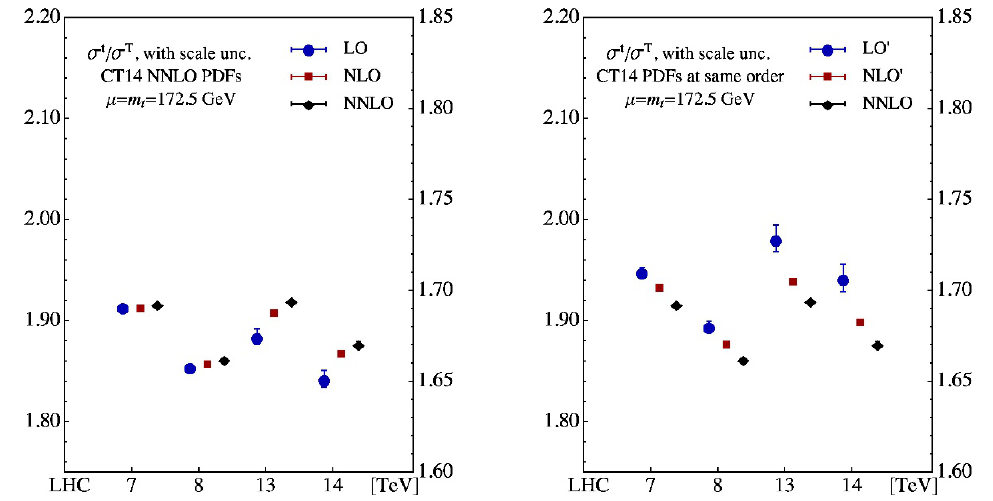
Figure 15 . Ratio of inclusive cross sections for t -channel single top quark and anti-quark produc- tion, similar to (cid:12)gure 12.